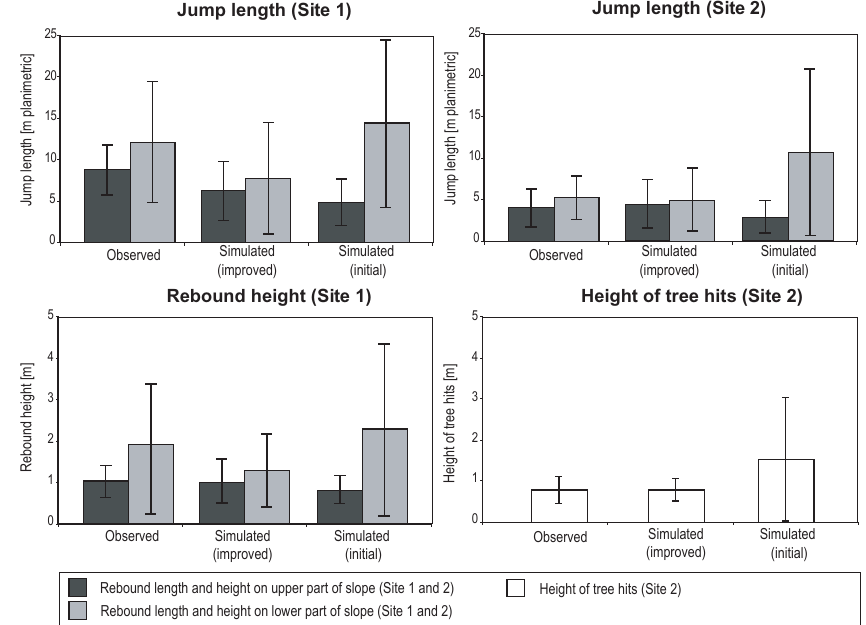
Fig. 3. Comparison of observed and simulated (initial, improved) rockfall parameters from both experimental sites in Vaujany. Jump lengths and rebound heights are taken from the upper and the lower part of the slope near the camera positions, height of tree hits from the entire slope at Site 2. Shown are mean values and standard deviation of 100 simulated rocks with 100 replicates